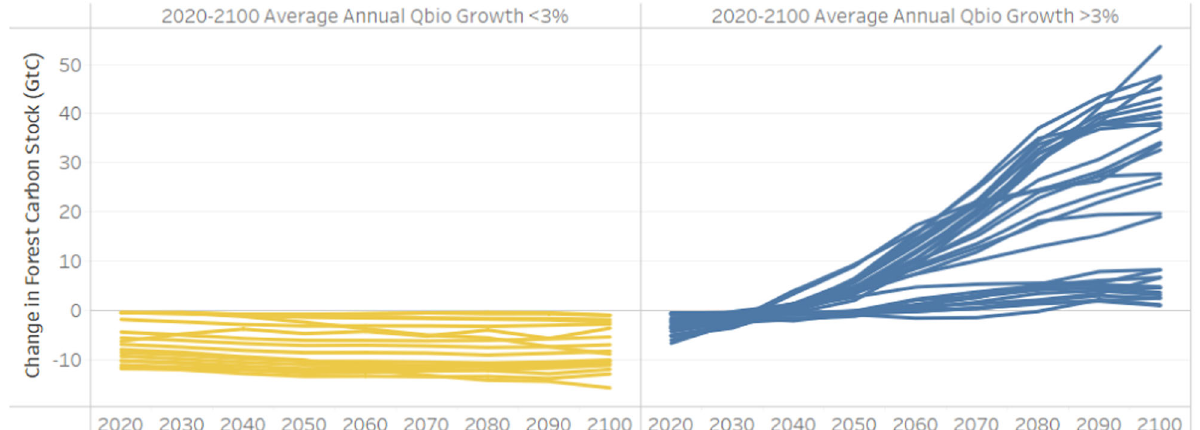
Fig. 2 Projected change in forest carbon stock in Giga tons of carbon (GtC) from baseline under the 51 forest biomass demand pathways (2020 – 2100). Yellow lines show the change in forest carbon stock from baseline under the demand scenarios with a growth rate below or equal to 3%. Blue lines show the change in forest carbon stock from baseline under the demand scenarios with an average growth rate greater than 3%. Positive values = more sequestration than the baseline (net sequestration), Negative value = less sequestration than the baseline (net